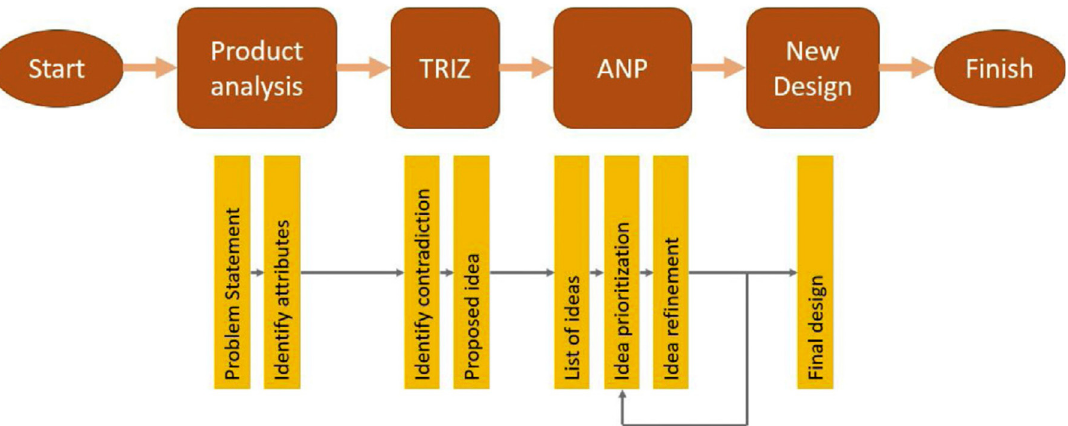
Figure 13. Application of TRIZ in concurrent engineering conceptual design framework for the development of a product [21]. Reproduced with copyright permission from Creative Commons Attribution License 3.0.